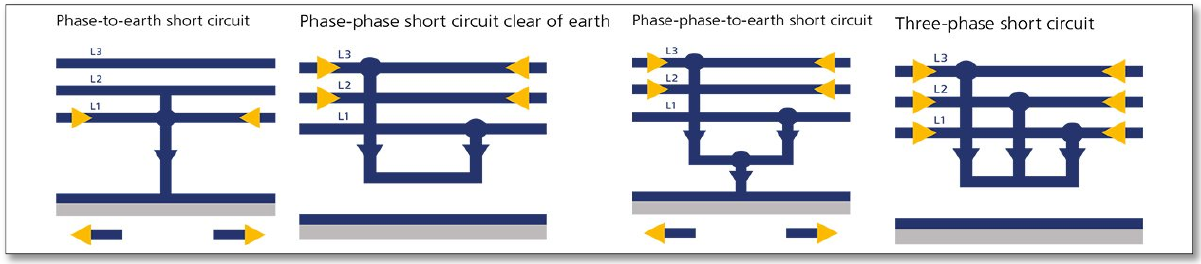
Figure 2. Short-circuit fault types.